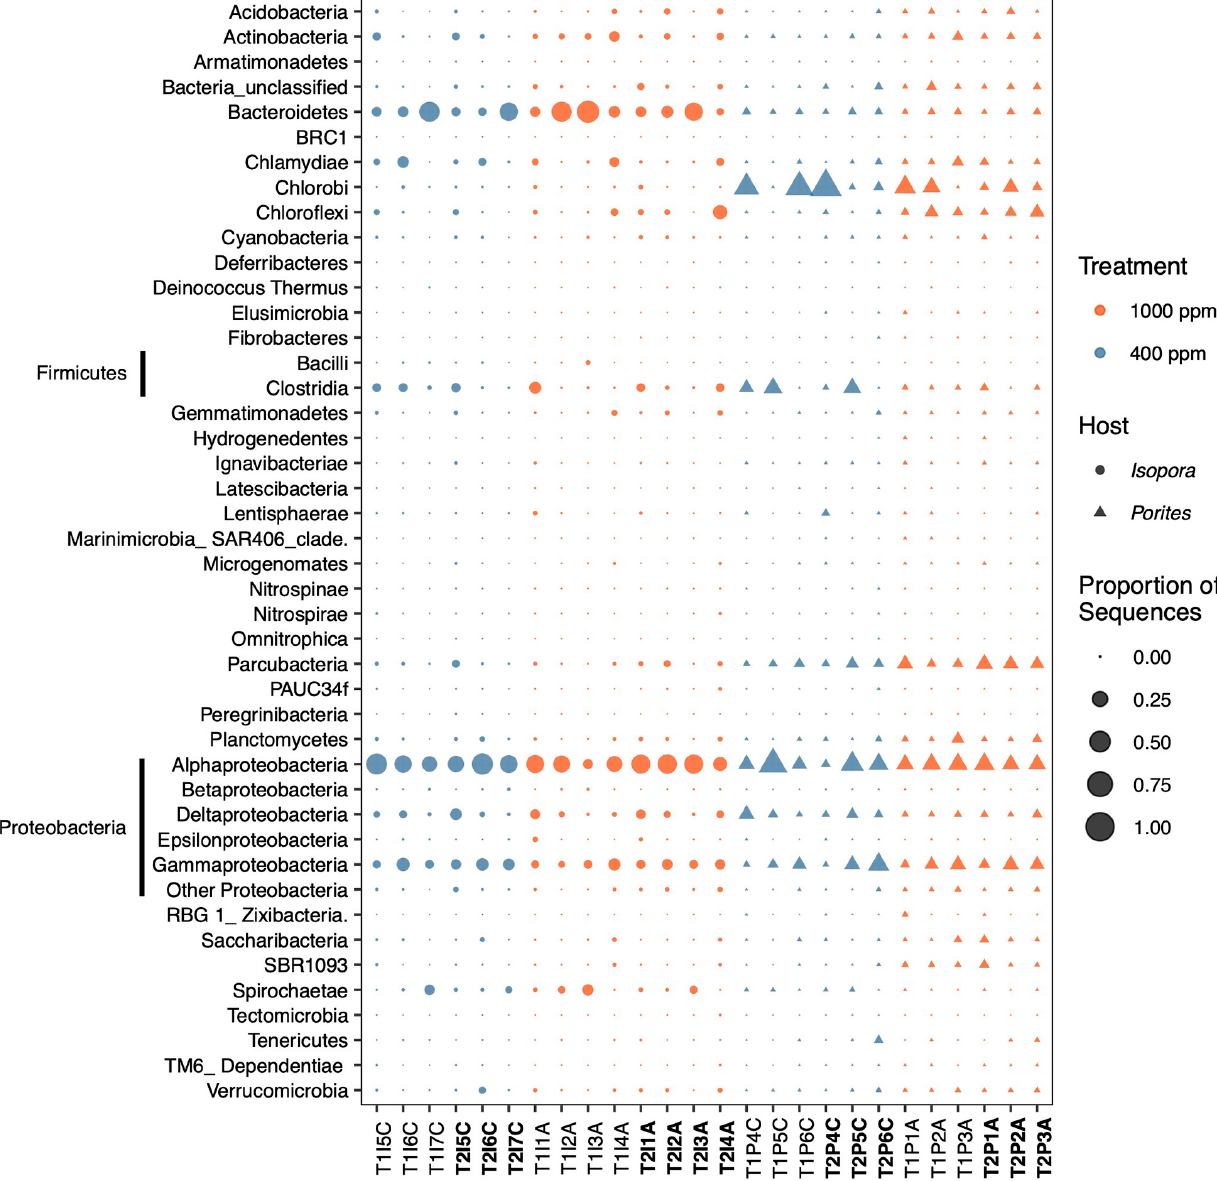
Frontiers in Marine Science |